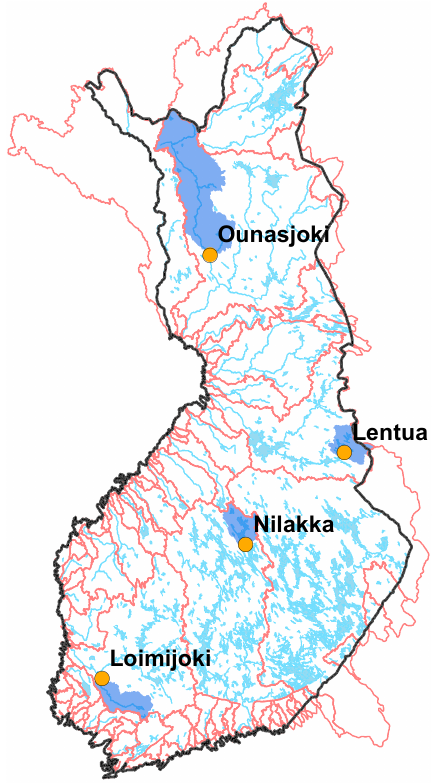
Figure 2. Map of the study catchments.